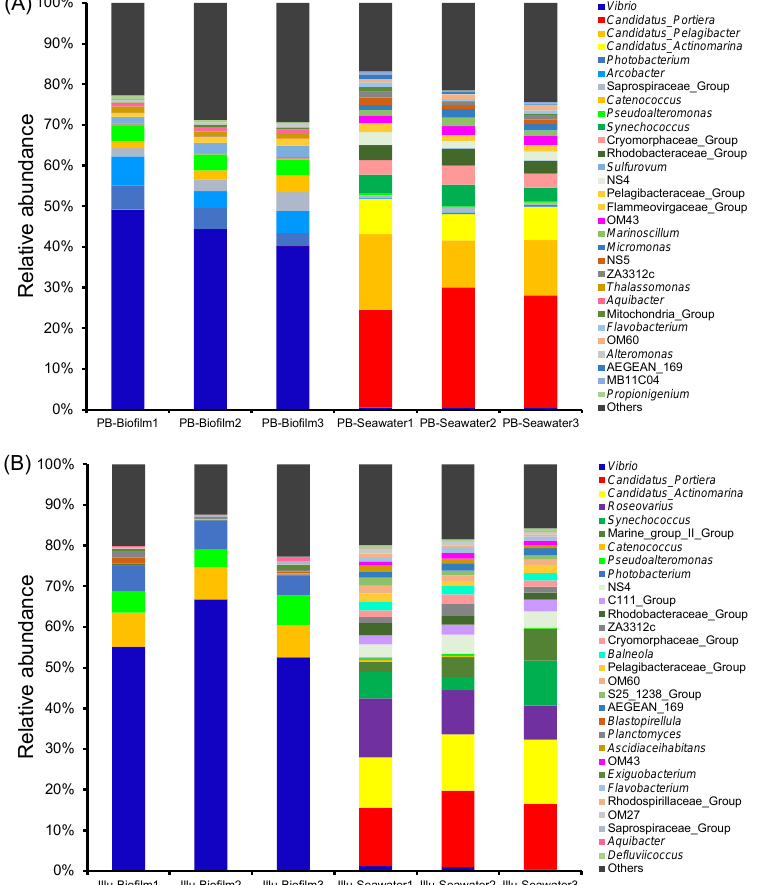
Figure 5. Genus-level taxonomic structure of biofilm and seawater samples. The top 30 abundant genera in terms of maximum relative abundance are shown, and the rest are merged into ‘Others’. ( A ) Biofilm and seawater microbial communities by PacBio sequencing. ( B ) Biofilm and seawater microbial communities by Illumina sequencing.